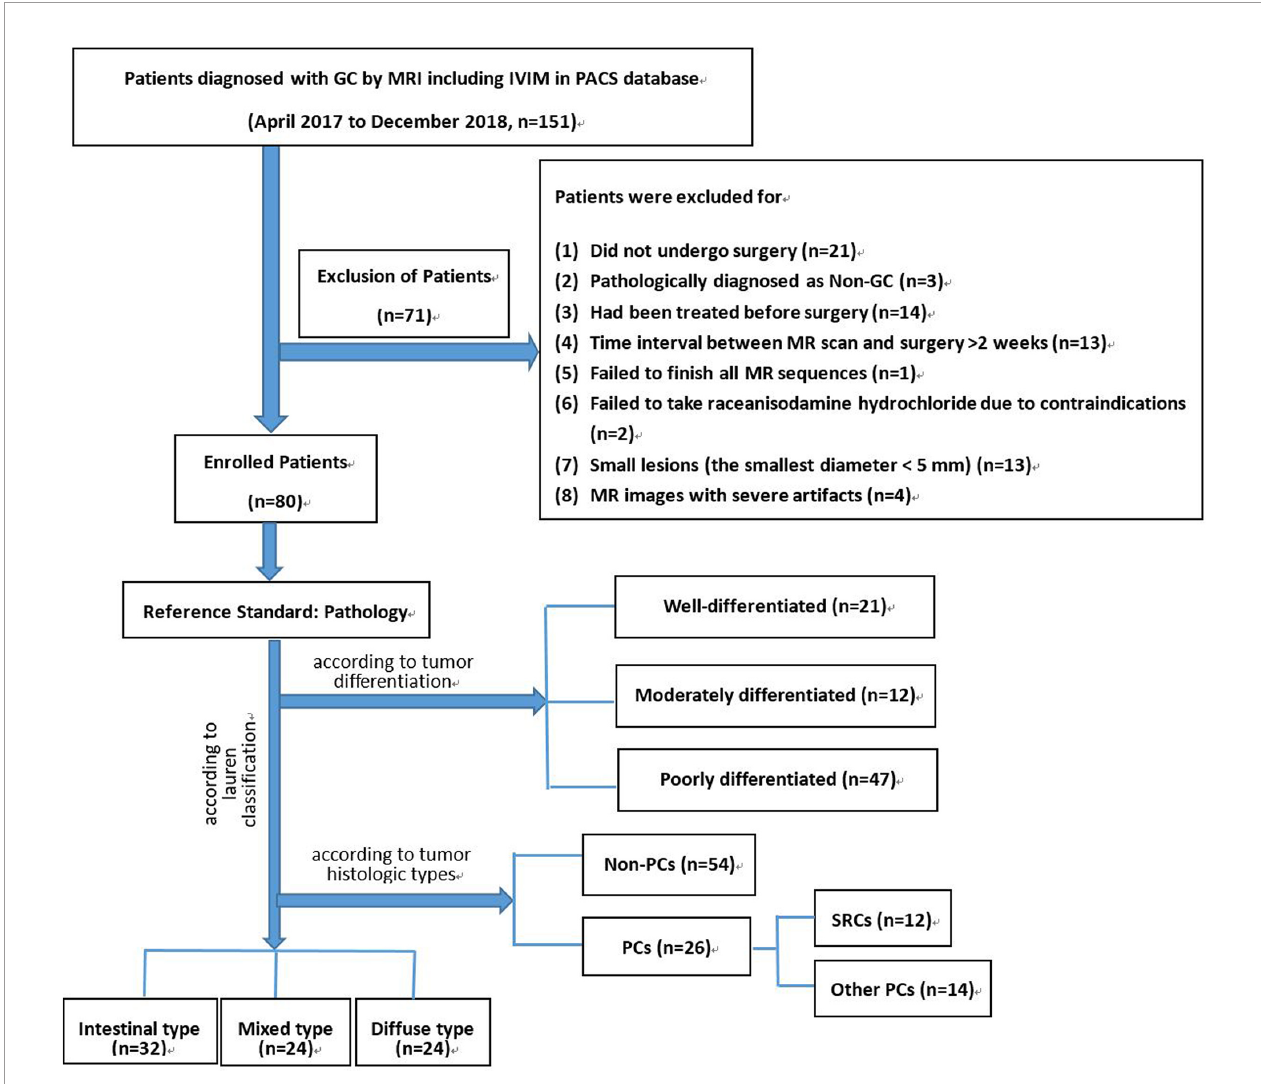
FIGURE 1 | Flow chart of our study population. GC, gastric cancer; IVIM, intravoxel incoherent motion; PACS, picture archiving and communication system; SRC, signet-ring cell carcinoma; PC, poorly cohesive